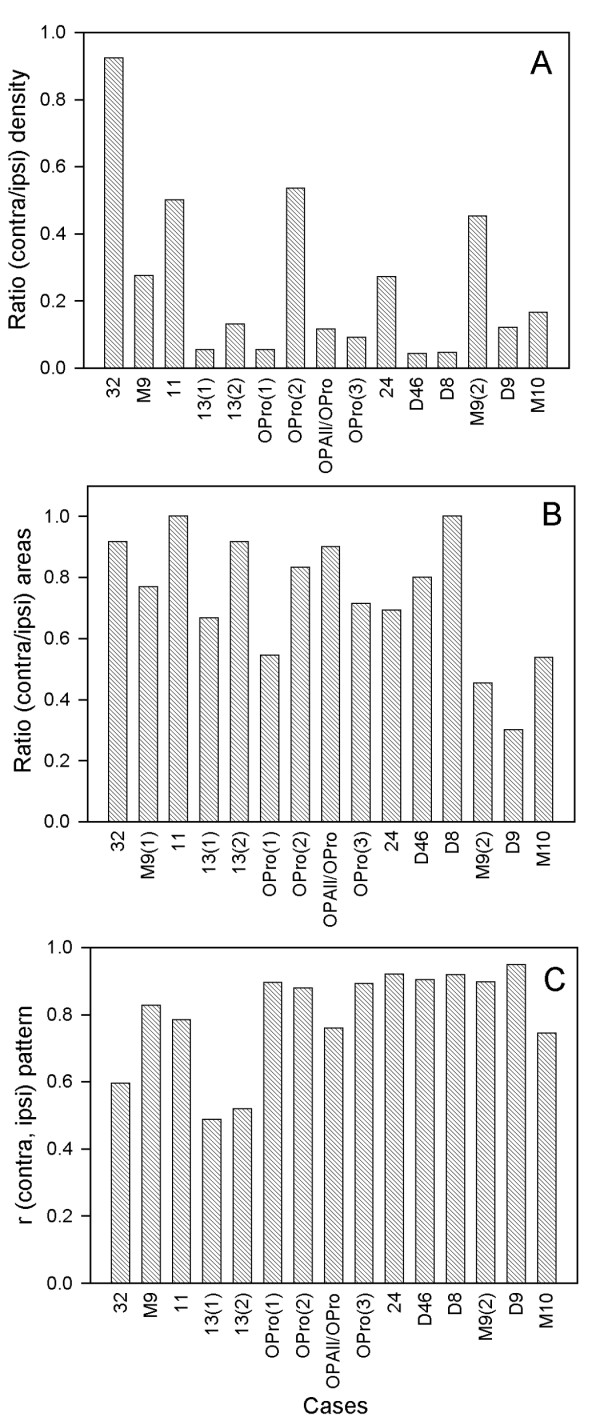
Comparison of contralateral to ipsilateral projections. Cases on the abscissa are identified by the area of the injection of neural tracer. Multiple cases with injection of tracers in the same area are identified by the number in parenthesis after each case. (A) Ratios of contralateral to ipsilateral projection densities. Values were calculated as the total number of contralateral neurons retrogradely labeled by an injection, divided by all labeled neurons ipsilaterally. (B) Ratios of contralateral to ipsilateral projection frequencies. Values were determined as the total number of areas with projection neurons on the contralateral side, divided by all areas with projection neurons in the ipsilateral hemisphere. Projections were included independently of their density and matching origins in the two hemispheres. (C) Strength of correlation between contralateral and ipsilateral projection patterns.